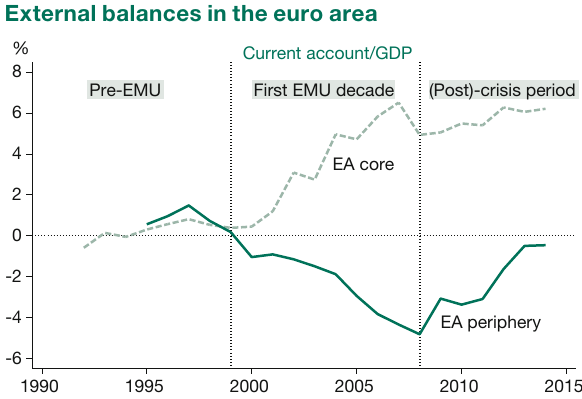
External balances in the euro